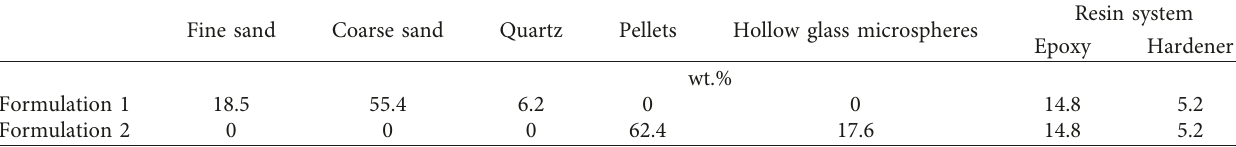
Table 4: Formulation compositions in